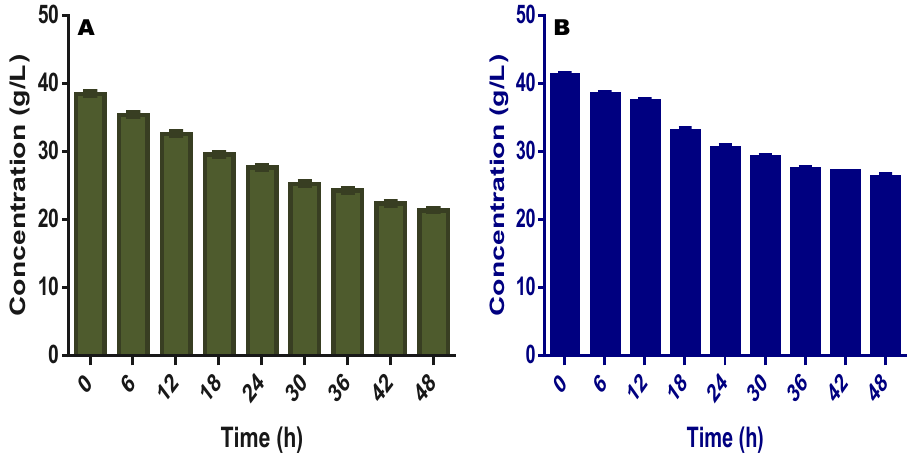
Figure 2. This figure shows the pattern of total solids (TS) conversion for ( A ) food wastes and ( B ) spent animal beddings during the experiments.